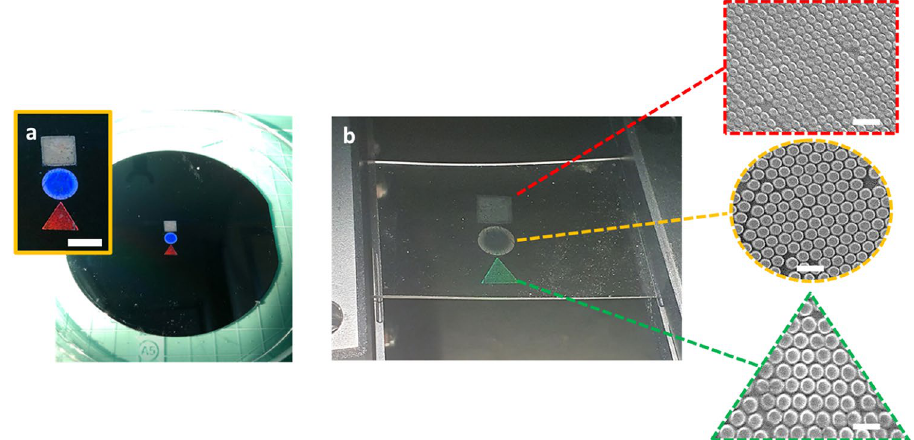
Figure 4. ( a ) Photo of the mold with 780, 510, and 356 nm periodic nanostructure in triangle, circle and square areas, respectively (scale bar 0.5 cm), ( b ) Photo of the sensor substrate and SEM images of 780, 510, and 356 nm periodic nanostructure in each area (scale bar 1 µm).